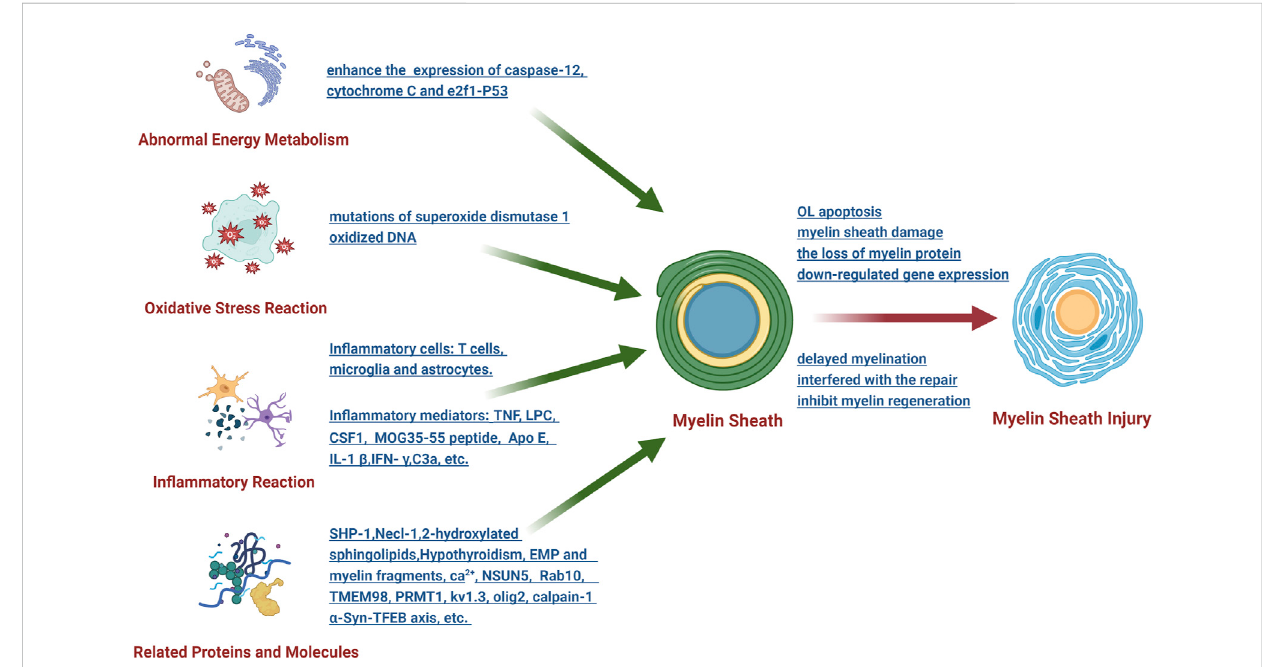
FIGURE 2 Schematic diagram of the research on the pathophysiological mechanism of myelin sheath injury after